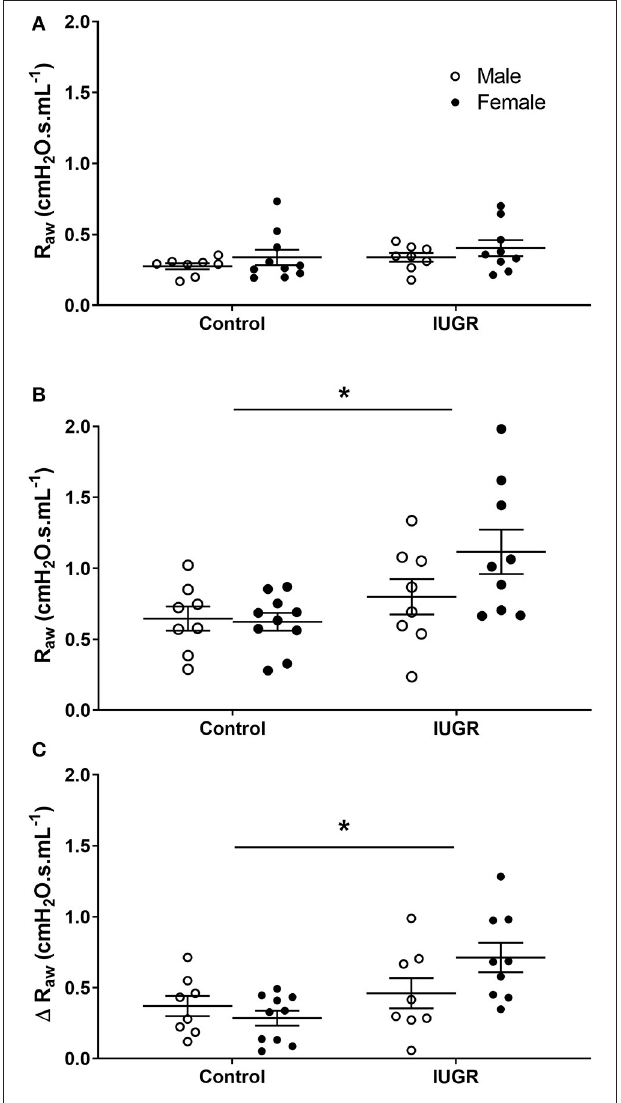
FIGURE 3 | Changes in R aw in Control and IUGR groups. Airway resistance in FIGURE 4 | Changes in R aw in Control and Allergy groups. Airway resistance Control male ( n 8) and female ( n 10), and IUGR male ( n 8) and female in Control male ( n 8) and female ( n 10), and Allergy male ( n 8) and = = = = = = ( n 9) offspring before (A) and after (B) MCh challenge, and 1 R aw (C) . Data female ( n 10) offspring before (A) , and after (B) MCh challenge, and 1 R aw = = are mean SEM. *Significantly different from Control ( P < 0.05). Males, open (C) . Data are mean SEM. *Significantly different from Control ( P < 0.05). ± ± circles; Females, closed circles; R aw , airway resistance; IUGR, intrauterine # Significantly different from males ( P < 0.05). Males, open circles; Females, growth restriction; MCh, methacholine; 1 , net change after MCh challenge. closed circles; R aw , airway resistance; MCh, methacholine; 1 , net change after MCh challenge.